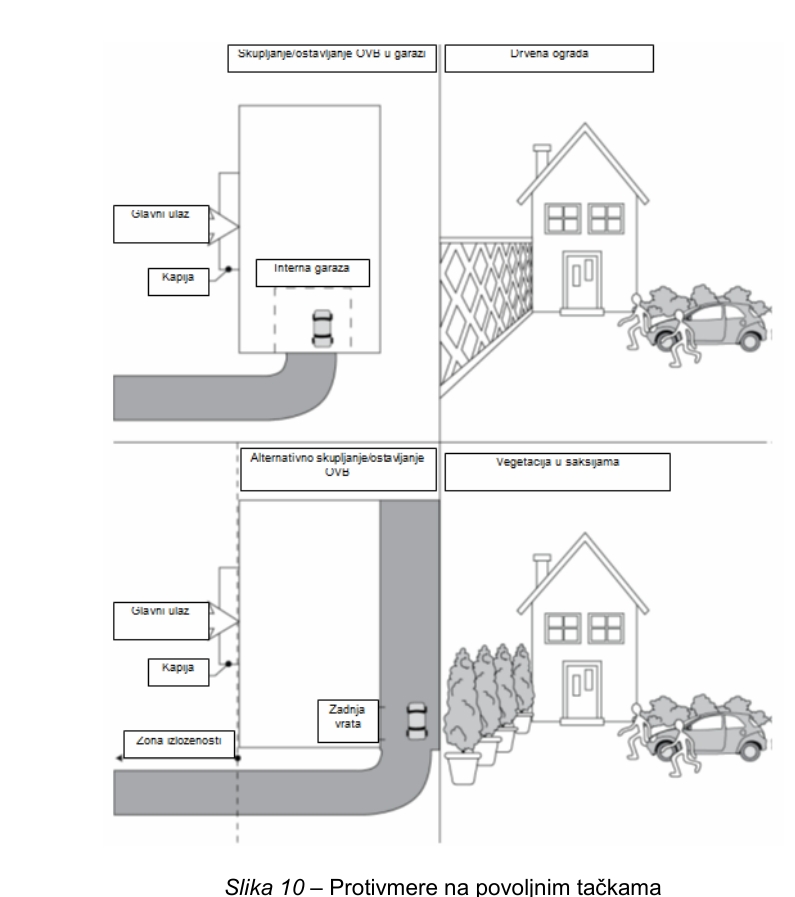
Figure 10 – Vantage point